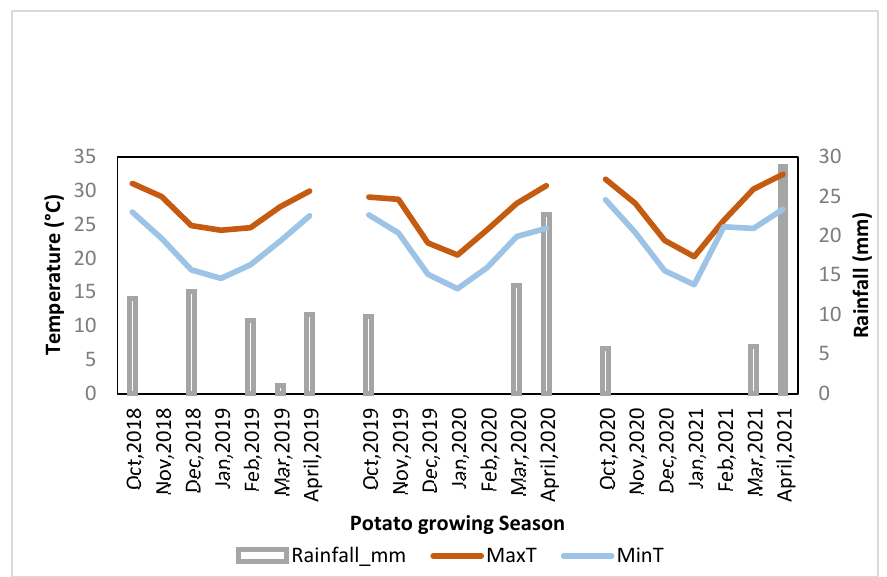
Figure 1. Monthly average temperature (maximum and minimum) and rainfall variation in Debiganj during the potato-growing season in 2018/2019, 2019/2020, and 2020/2021.